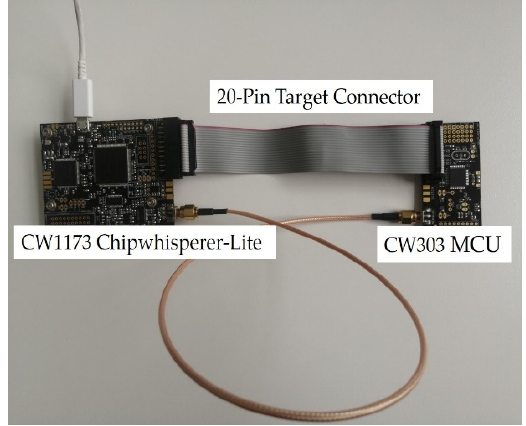
Figure 2. The connection of the power collection device.